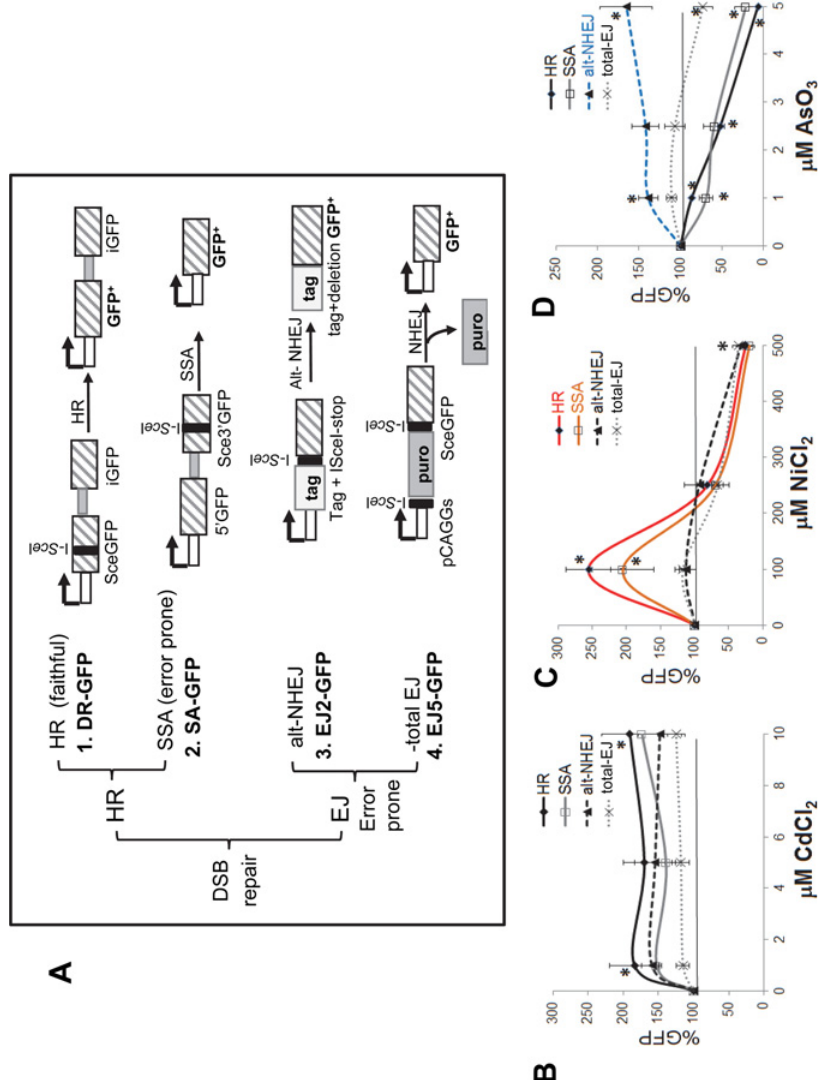
Fig 1. Exposure to different heavy metals alters the selection of DNA repair pathway used to repair exogenously induced double strand breaks. A. A schematic of the four green fluorescent protein (GFP)- based reporter cassettes are shown. These reporter cassettes are designed to provide quantitative information on the outcome of the double strand break (DSB) repair [23]. The exogenously induced DSBs